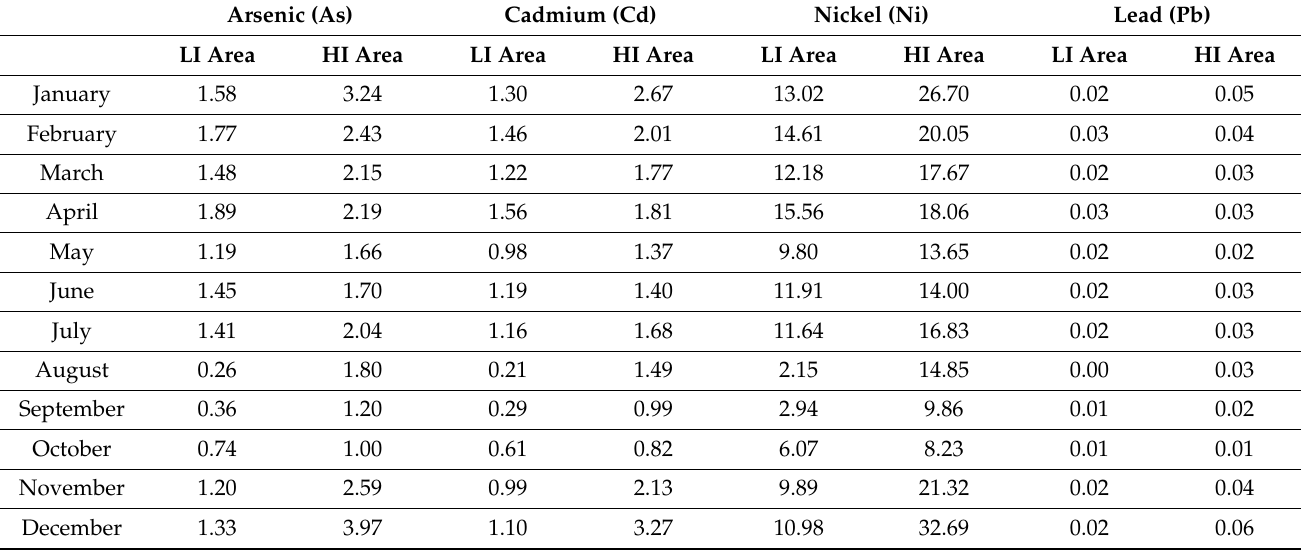
Table 5. Chronicle Daily Intake Expressed in µ